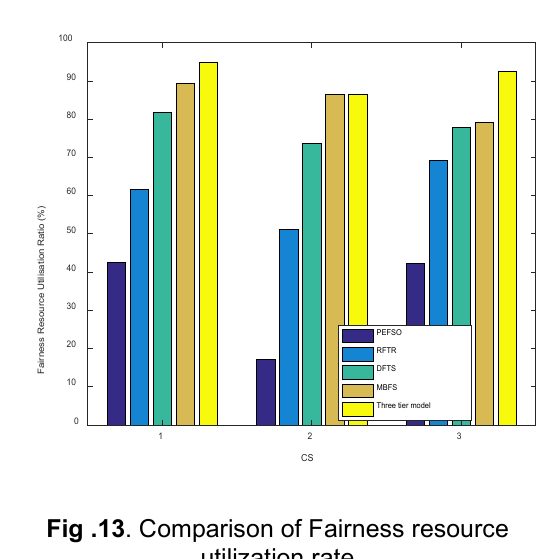
Fig .12 . Total time taken by CS 1-3